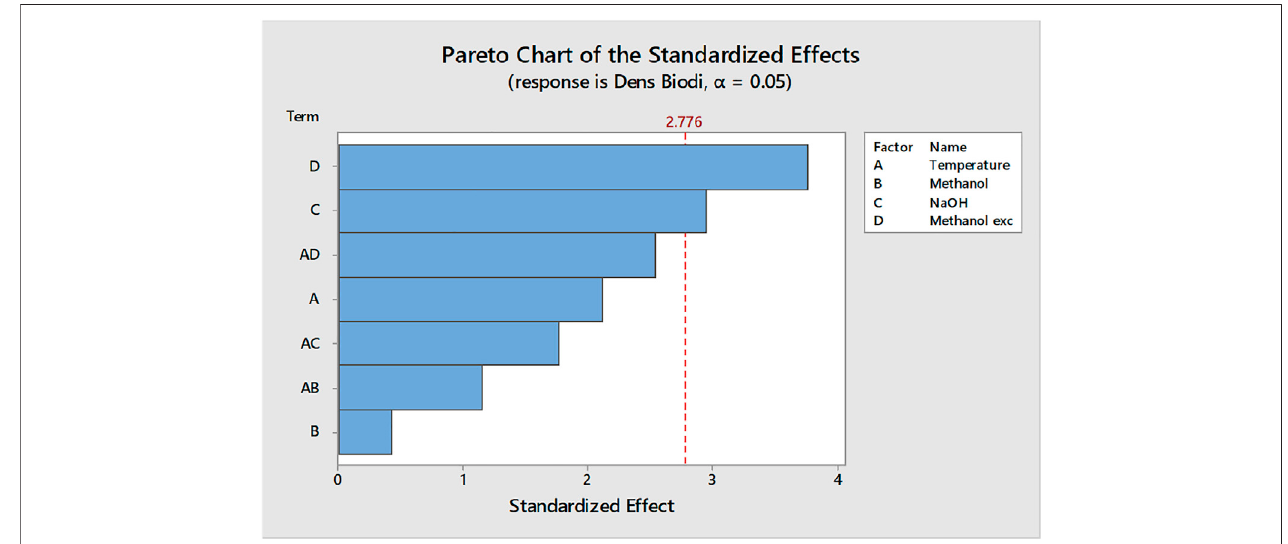
FIGURE 4 | Main factors that impact the fi nal density of FAME.